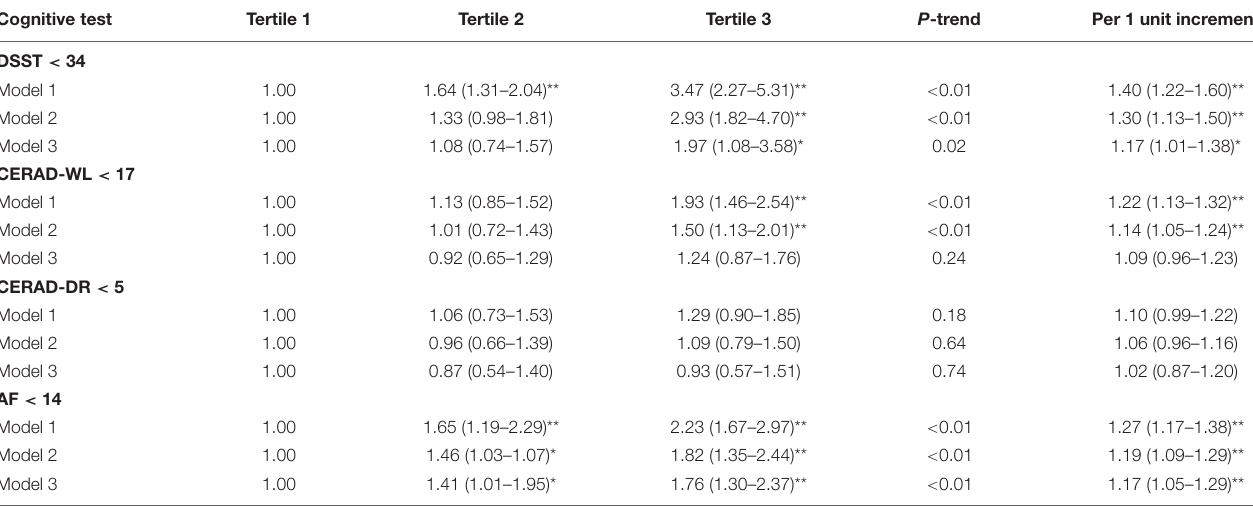
TABLE 2 | Odds ratios (95% confidence intervals) of lower cognitive functioning by dietary inflammatory index scores. Cognitive test Tertile